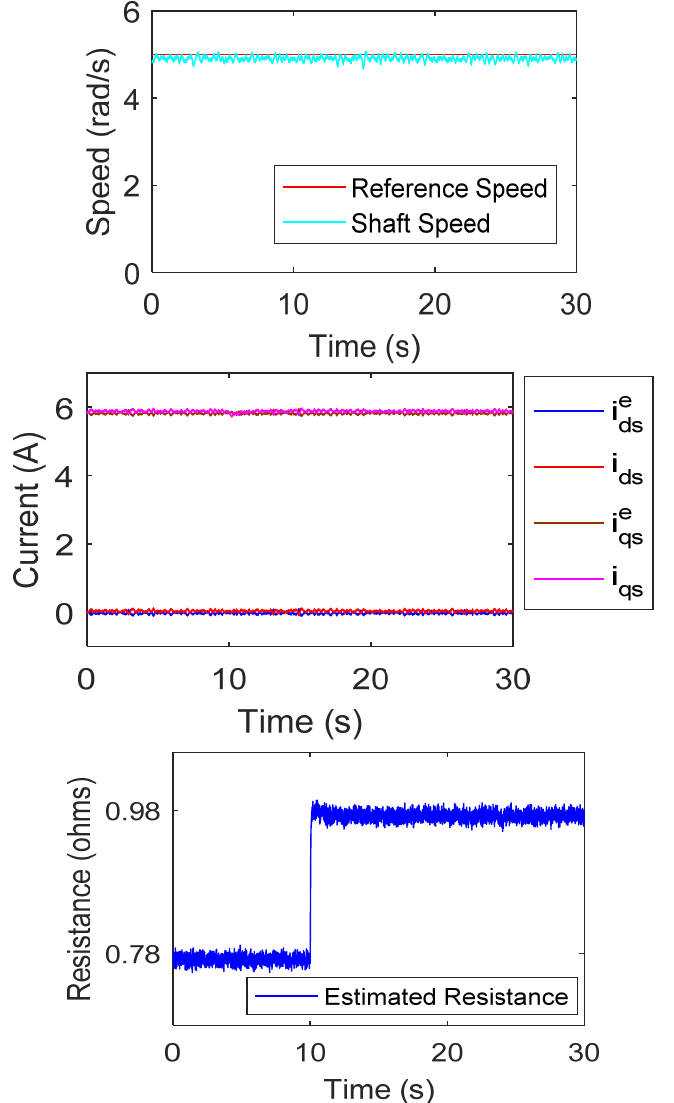
Figure 14 . Experimental results for the online stator-resistance estimation and compensation. Figure 14. Experimental results for the online stator-resistance estimation and